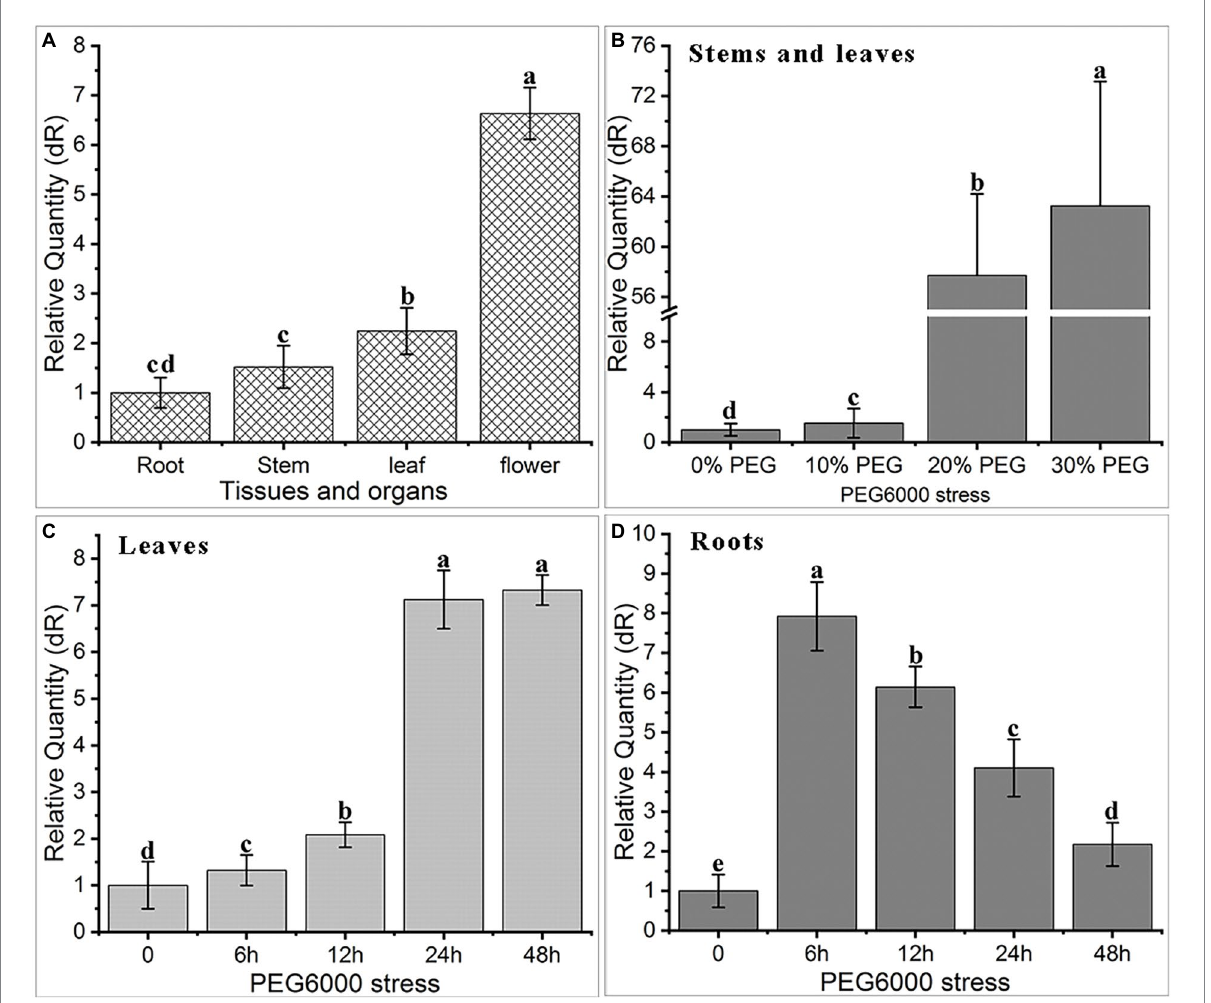
FIGURE 3 Expression characteristics of AfNAC1 gene in tissue organs and under PEG6000 stress. (A) Tissue organs: root, stem, leaf, and flower; (B) 0, 10, 20, and 30% PEG6000 stress; (C) leaves under 0, 6, 12, 24, and 48 h PEG6000 stress; (D) roots under 0, 6, 12, 24, and 48 h PEG6000 stress; error lines indicate standard error of three biological replicates, significant difference at p < 0.05